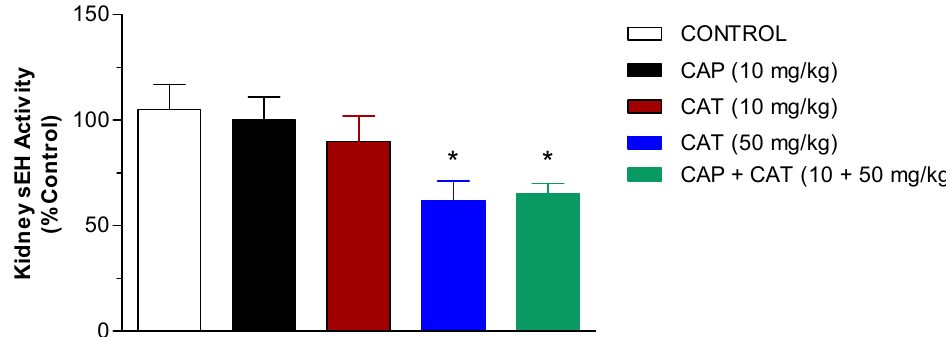
Figure 5. Effect of five week-daily oral treatment of SHR with catechin (CAT) and captopril (CAP) on soluble epoxide hydrolase (sEH) activity in rat kidney cytosols. Data are presented as the mean ± SEM ( n = 6–9). * Significant difference from control group at 5 weeks, p < 0.05.